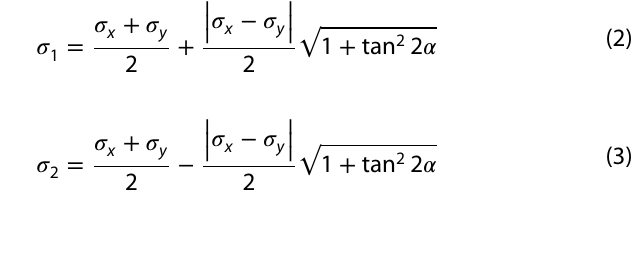
Fig. 2 Paleo-tectonic and paleo-tectonic stress field in northeast